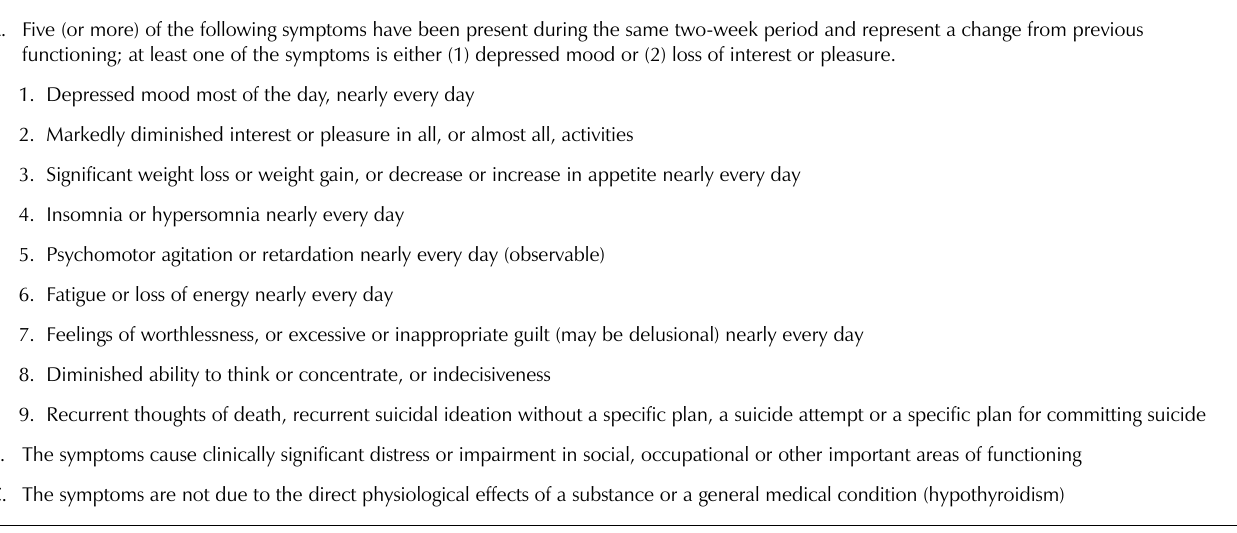
Diagnostic and Statistical Manual of Mental Disorders, Fourth Edition, Text revision criteria for a major depressive episode A. Five (or more) of the following symptoms have been present during the same two-week period and represent a change from previous functioning; at least one of the symptoms is either (1) depressed mood or (2) loss of interest or